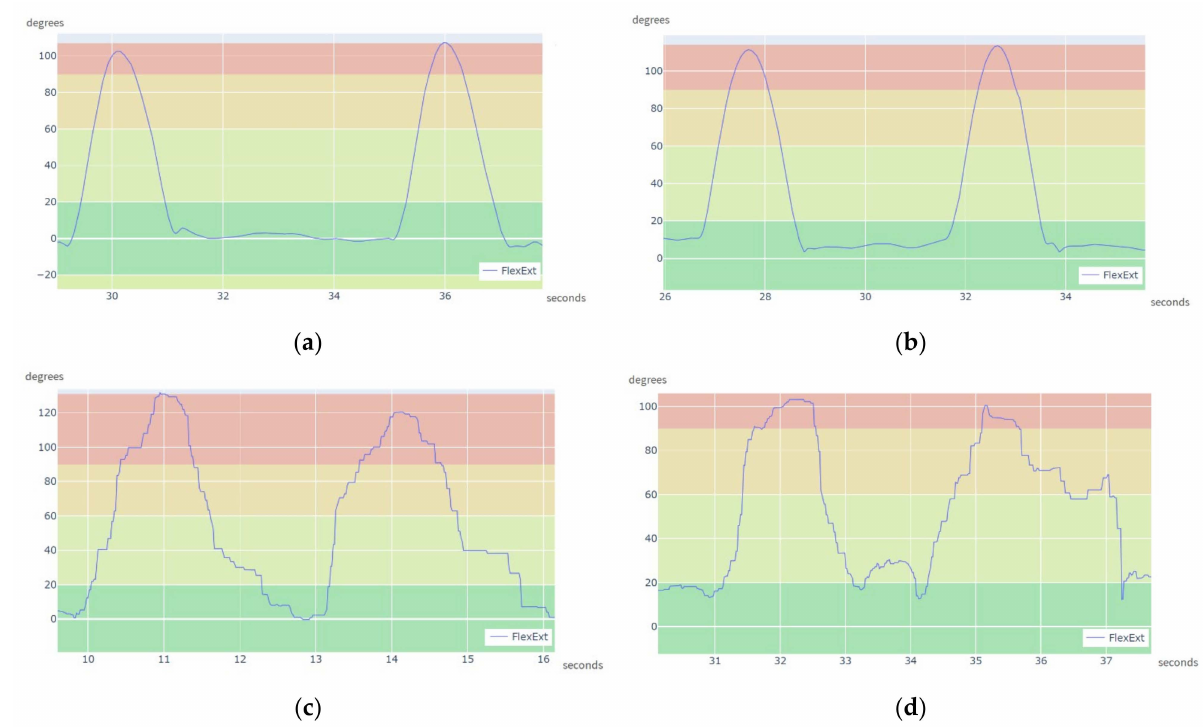
Figure 15. Computation angle in detail for crowded environment: ( a ) Left Shoulder angle from CW sensors data; ( b ) Right Shoulder angle from CW sensors data; ( c ) Left Shoulder angle from XDOT data; ( d ) Right Shoulder angle from XDOT